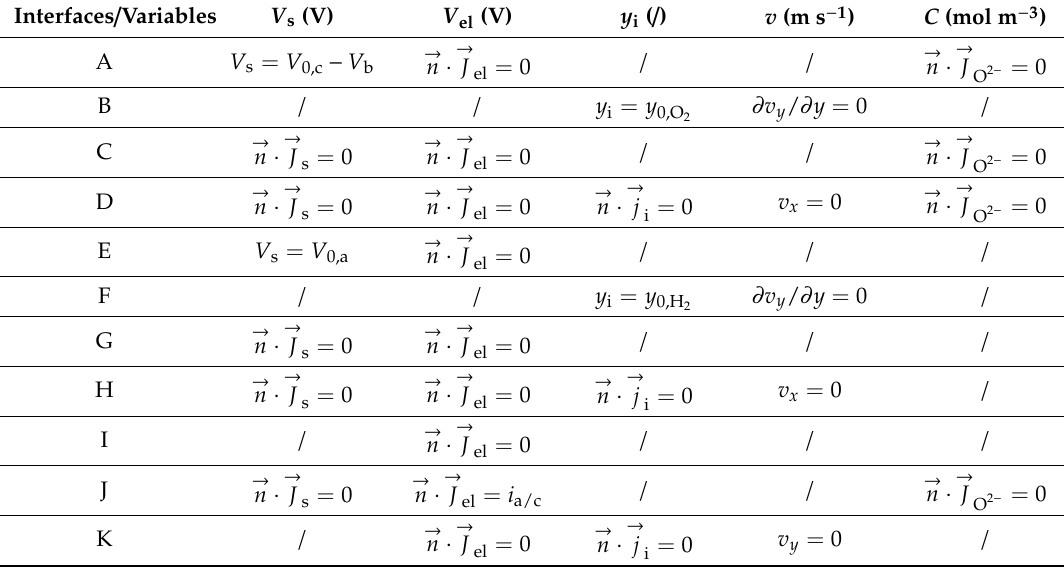
Figure 3. Schematic of interfaces in the modeled domain. Table 1. The boundary conditions.